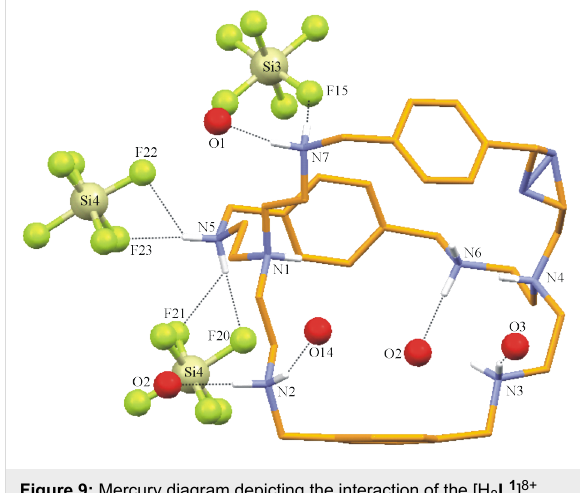
Figure 9: Mercury diagram depicting the interaction of the [H 8 L 1 ] 8+ with the surrounding molecules via N–H···F and N–H···O hydrogen